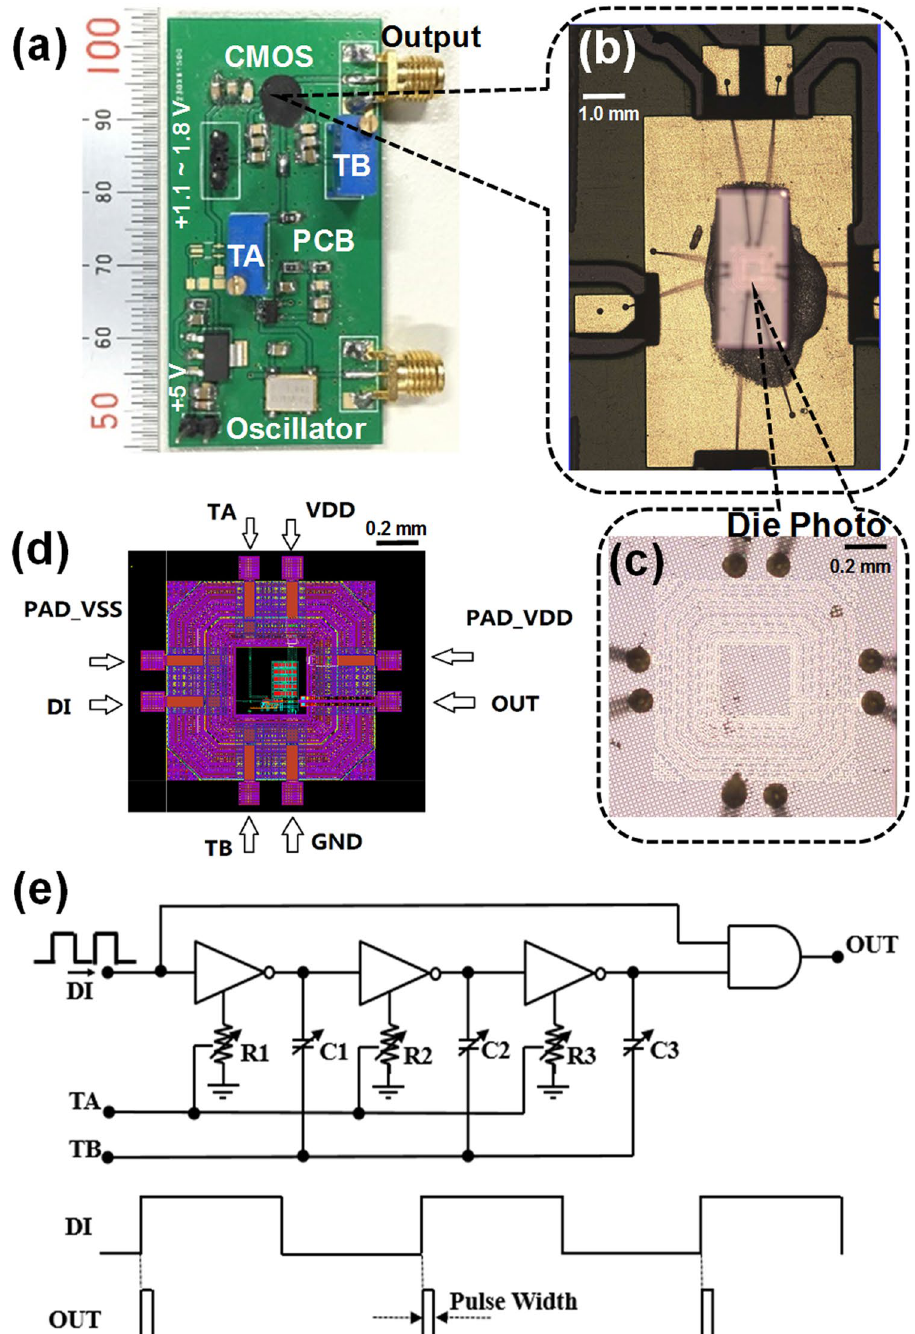
Figure 1. Schematic design and images of the electric pulser. ( a ) Image of the lab-made electric pulser on a printed circuit board (PCB). ( b ) Image of the CMOS pulse generator taken before packaging on the PCB. ( c ) Enlarged image of the CMOS pulse generator. ( d ) Design layout of the CMOS pulse generator. ( e ) Schematic design of the CMOS circuit. TA: Tuning A, TB: Tuning B, DI: Data Input, VDD: Voltage Drain Drain, VSS: Voltage Source Source, GND: